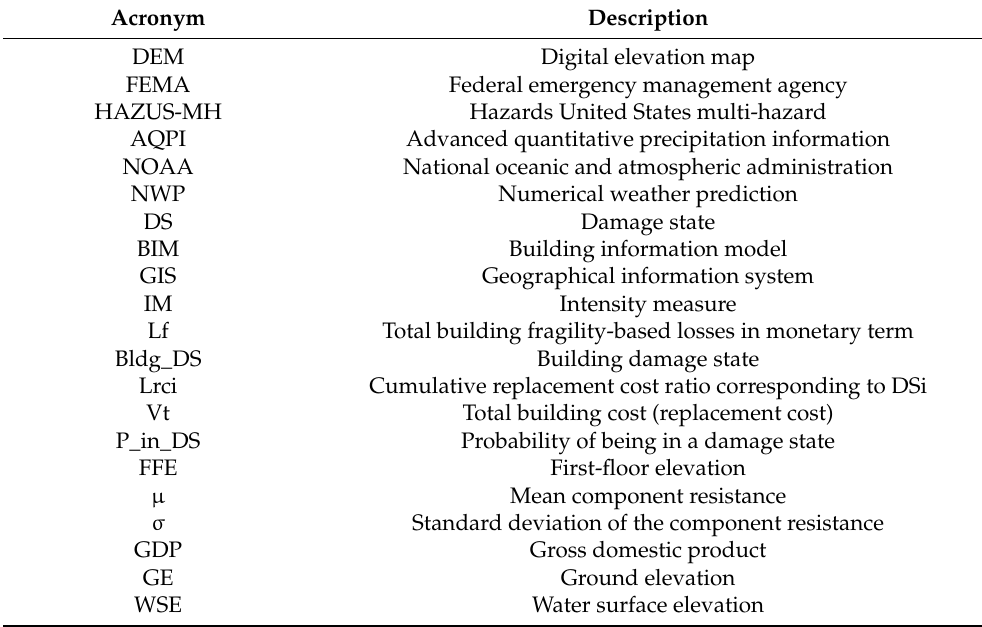
Table 1. Acronym